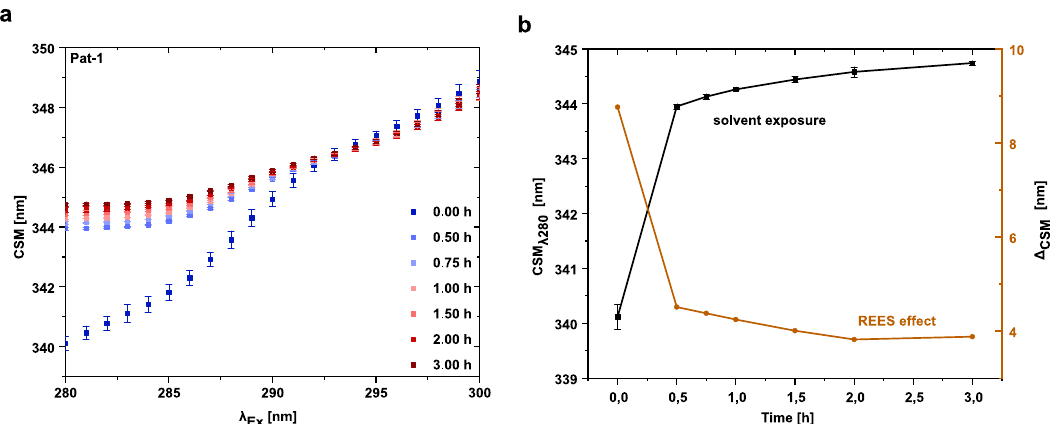
Fig. 5 The REES effect of Pat-1 V L during the lag phase. a Change in the CSM for the corresponding excitation wavelengths from 280 to 300 nm. b Conclusion of the REES effect (orange) and solvent exposure (black) at the different timepoints. Measurements were carried out in triplicates. Error bars respresent the respective SEM of the